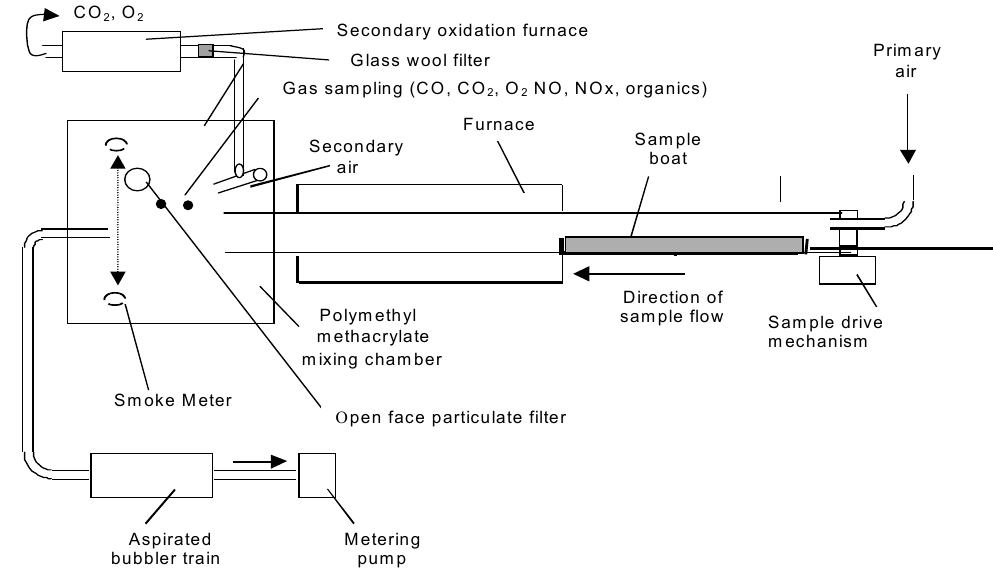
Figure 2. ISO TS19700 steady state tube furnace (SSTF).